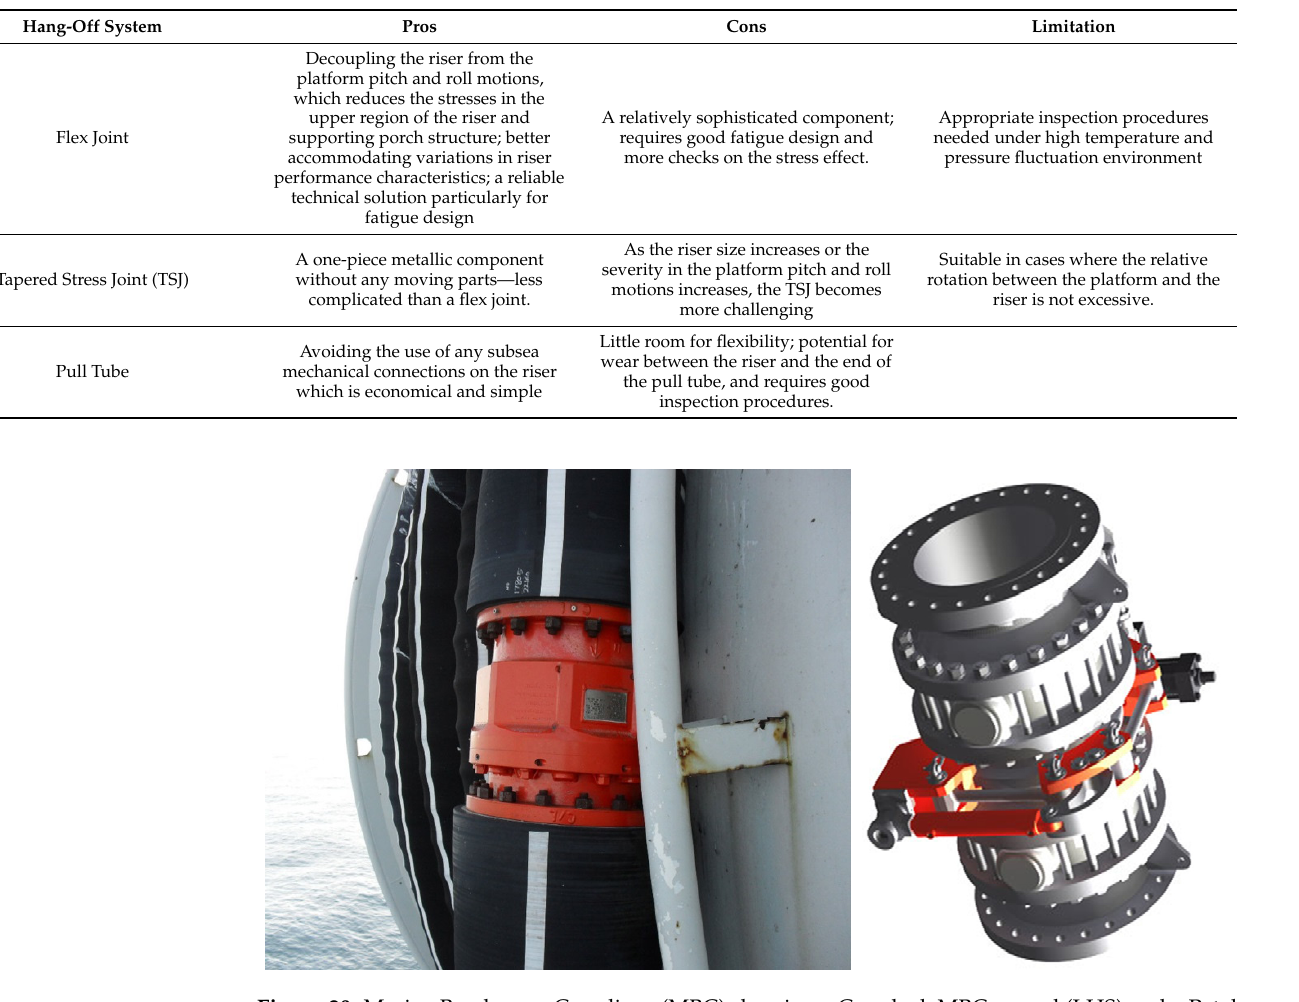
Figure 20. Marine Breakaway Couplings (MBC) showing a Cam-lock MBC on reel (LHS) and a Petal MBC (RHS).